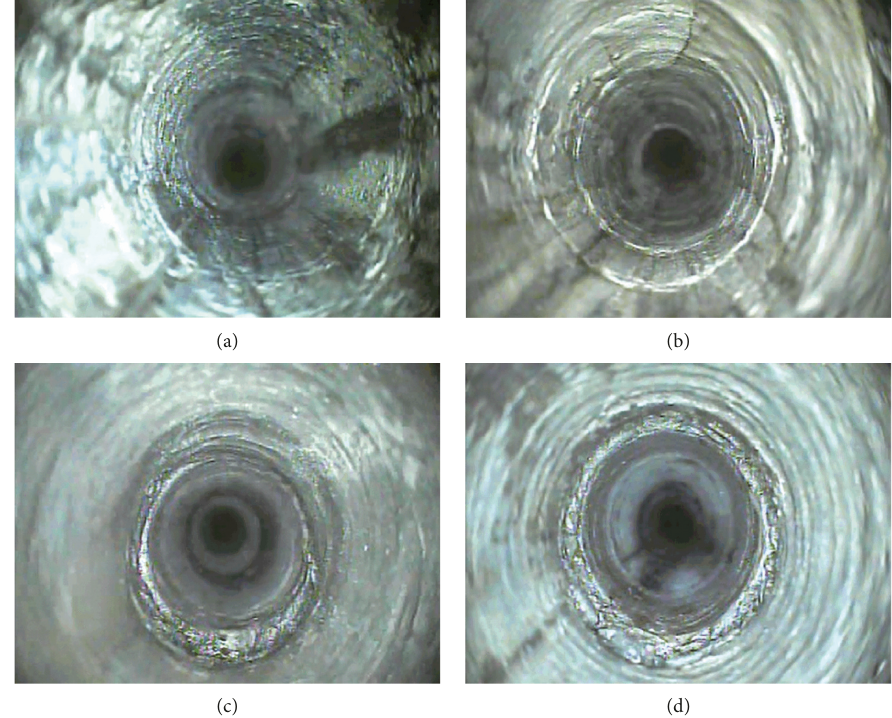
Figure 11: Video capture of the roof detection borehole. (a) Intact roof strata. (b) Fracture. (c) Crack. (d) Broken.